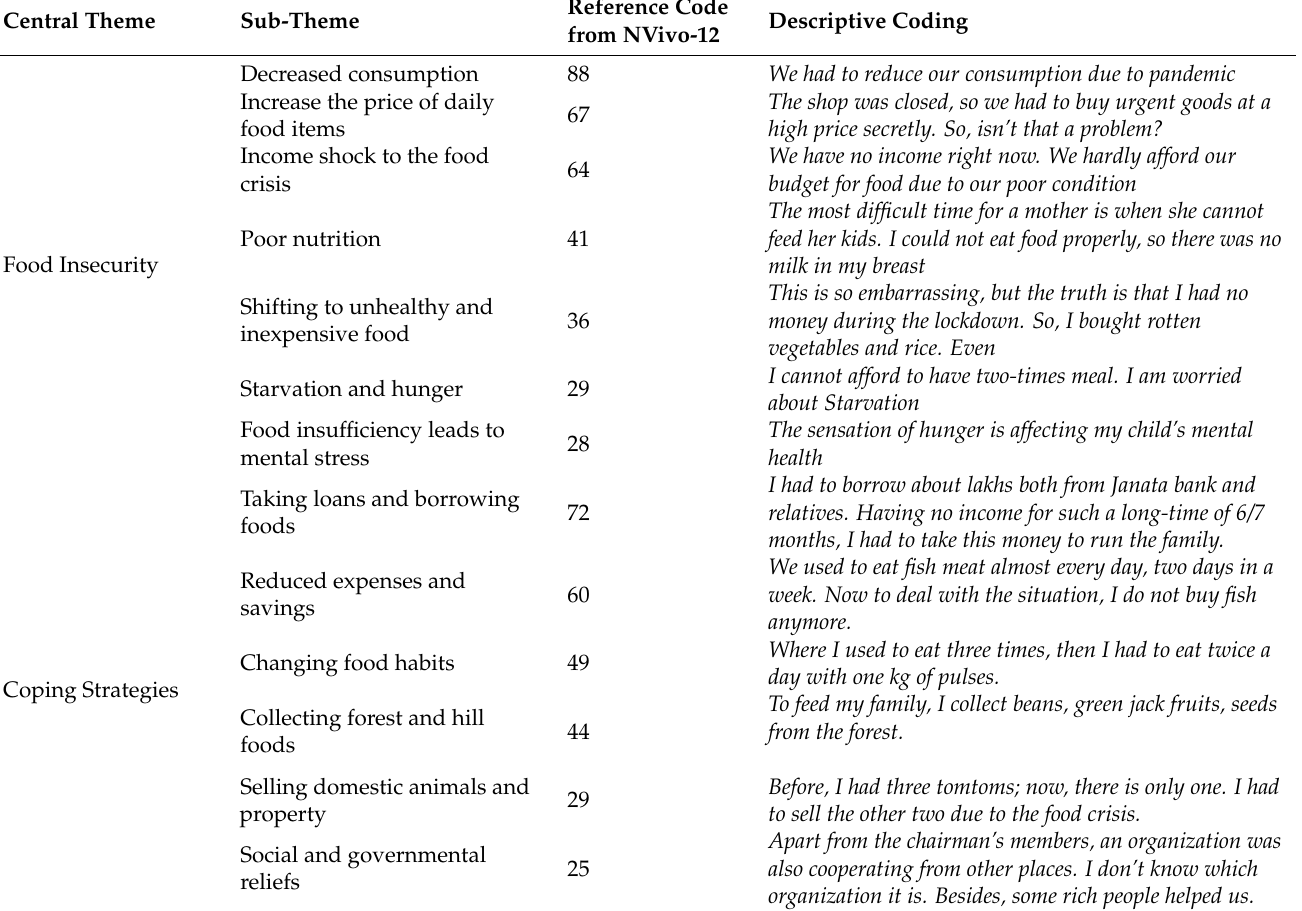
Table 4. Defined themes that were derived from the thematic analysis.